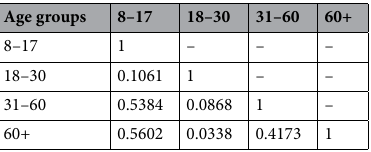
Table 7. P-values based on paired Wilcoxon tests for UX scores from four age groups.